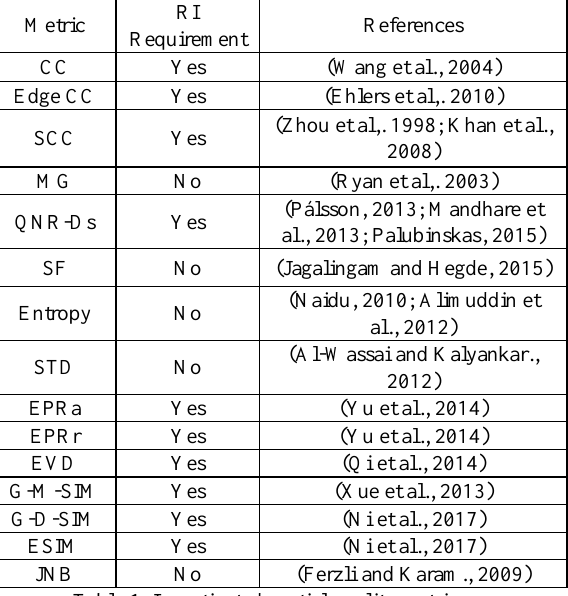
Table 1. Investigated spatial quality